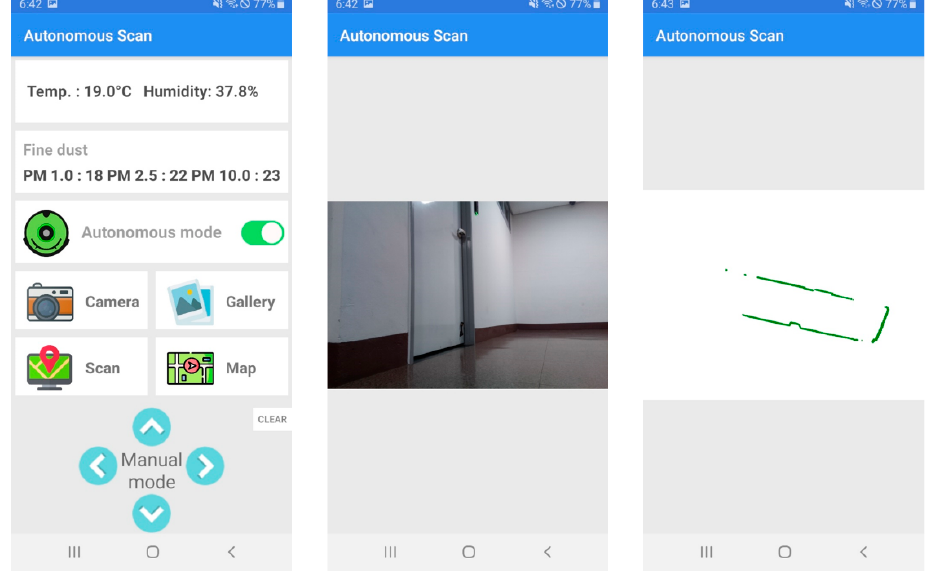
Figure 27. Environmental data result ( left ), captured image ( middle ), and scanned result ( right ) at position (marked 6 in Figure 23) from which second autonomous scanning experiment was performed.